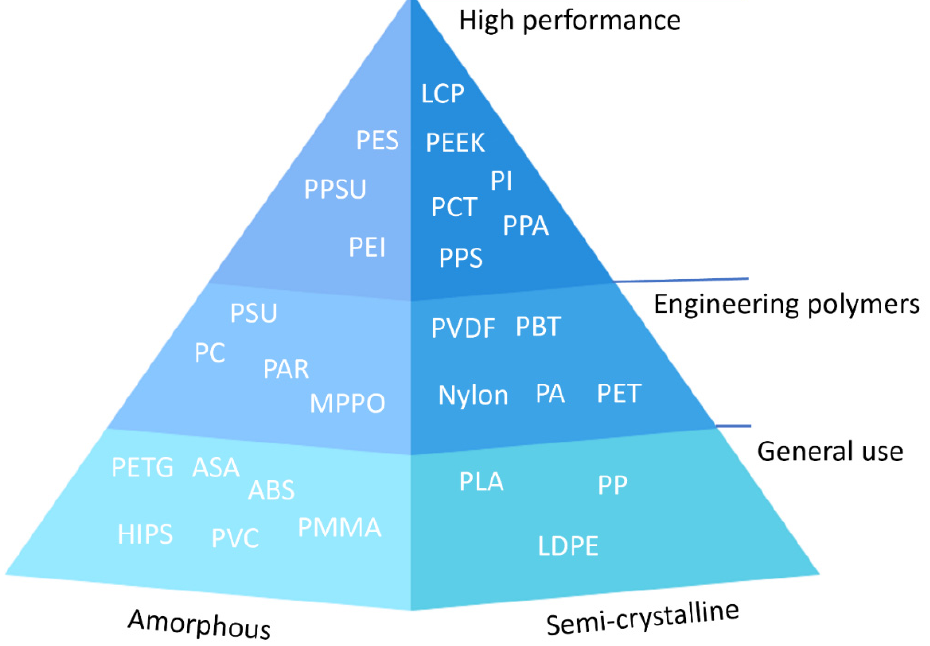
Figure 1. Different types of thermoplastics polymer.